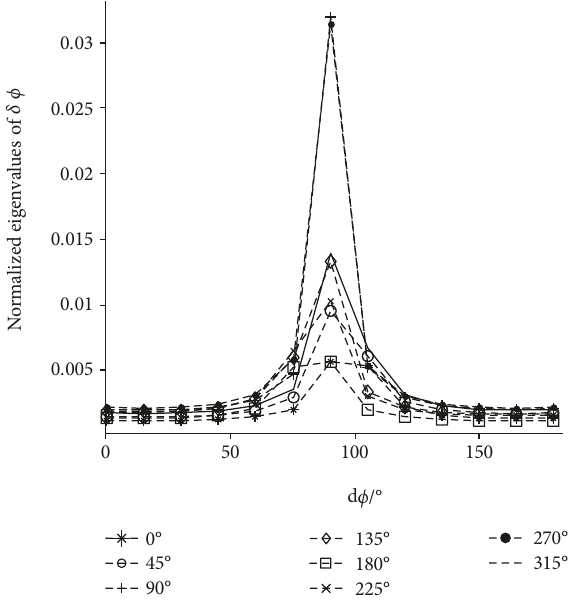
Figure 9: Normalized eigenvalues of the heading angle error δϕ under di ff erent current directions.